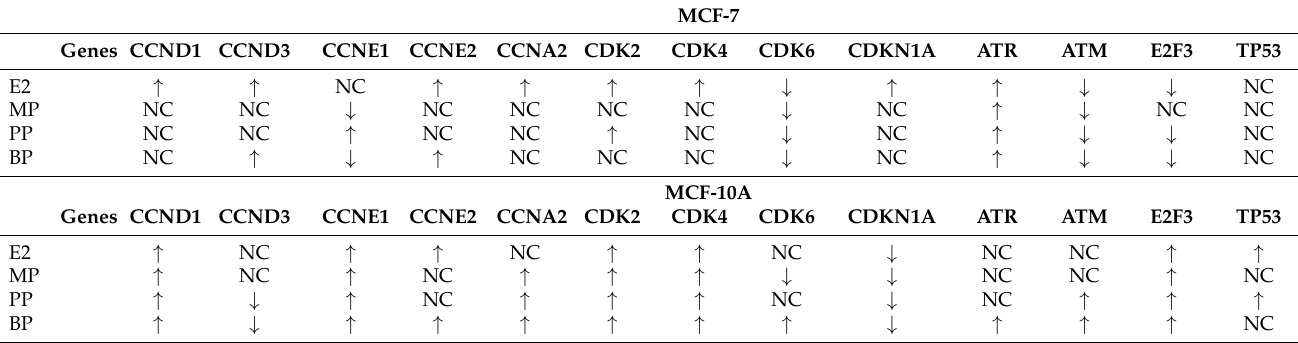
Table 3. Effect of 17- β Estradiol (E2) and Parabens on the Expression of Selected Genes in MCF-7 and MCF-10A